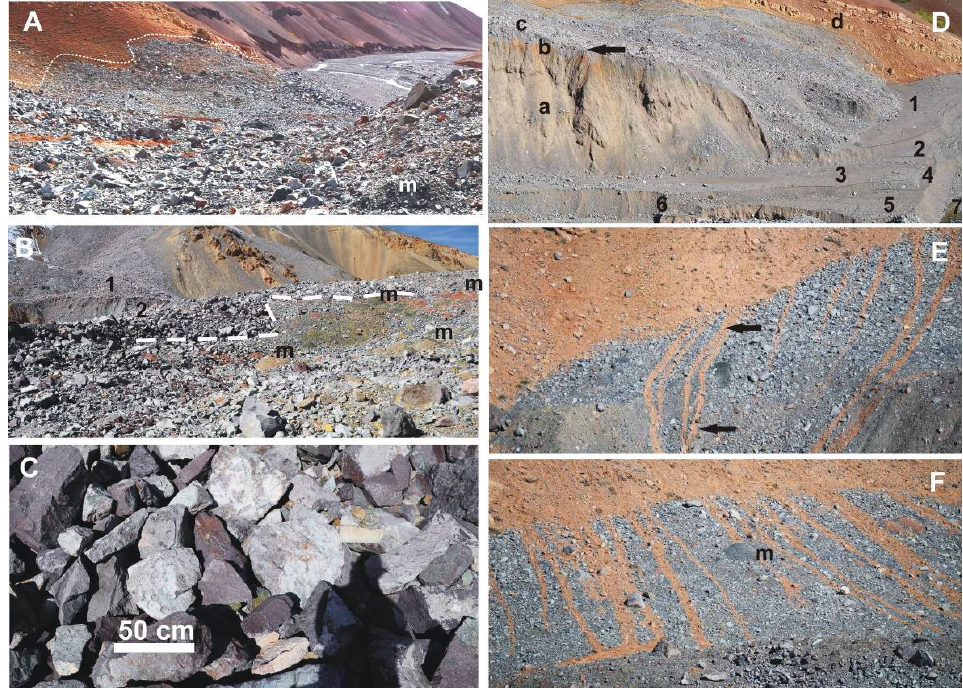
Figure 9. Details of Flow 2 deposit. ( A ) Lobate boundary of Flow 2 at its more distal reach. Note the sheet-like shape and sparse molards (m). ( B ) Minor changes on the thickness of Flow 2 (hatched line) suggest the existence of internal lobes. It also shows the irregular distribution of molards (m) across the deposit. Numbers 1 and 2 point to the shoulders of the pre-existing incised canyon that Flow 2 would have completely filled up. ( C ) A view of the lack of fines and lack of effect of abrasion on boulders of Flow 2 deposit. Scale bar is 50 cm. ( D ) A view of one of the canyon walls (marked 1 in ( B ), showing it was excavated over previous mass-wasting deposits (a) partially covered by reddish scree (b), derived from the sedimentary Mesozoic units (d), and topped by the thin deposit ascribed to Flow 2 (c). Note also the depositional terraces formed by the outburst flow, numbered 1–6, with 7 being the 2012 river level. ( E , F ) Views of the distal end of Flow 2 deposit where it is abnormally thin, as shallow rilling exposed the underlying Mesozoic red